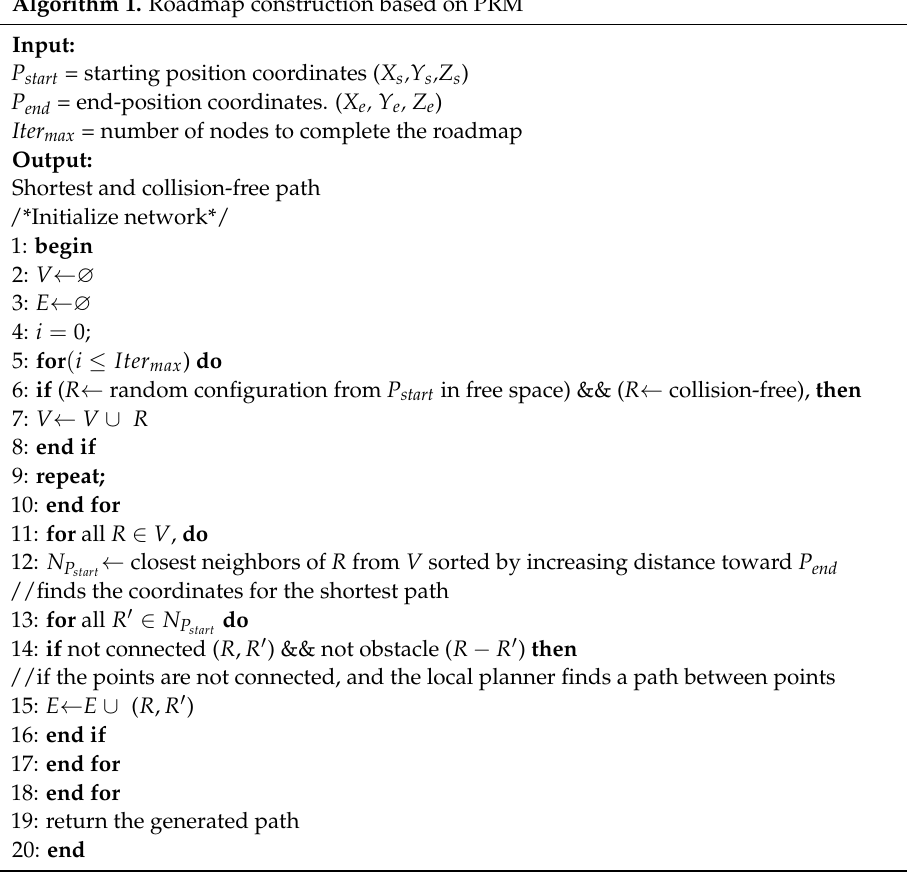
Algorithm 1. Roadmap construction based on